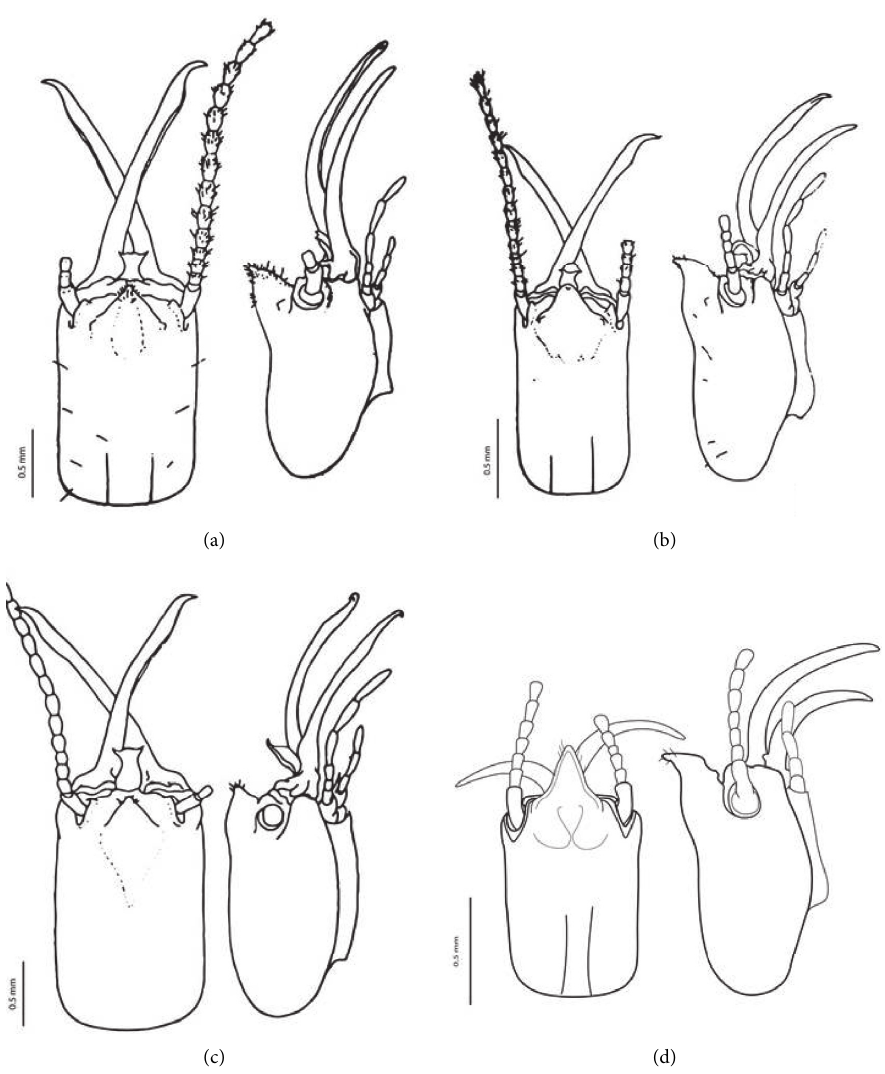
Figure 2: Dorsal and lateral views of head of the soldier caste. (a) Termes comis, (b) T. rostratus, (c) T. laticornis, and (d) T. propinquus. (a- c) Redrawn with minor editorial modification from Tho (1992), (d) drawn from the specimen